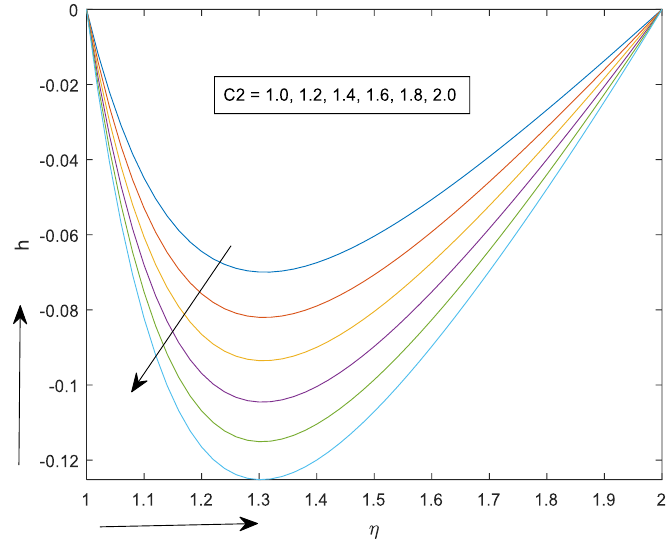
Figure 9. Angular velocity profile for different values of 𝐶